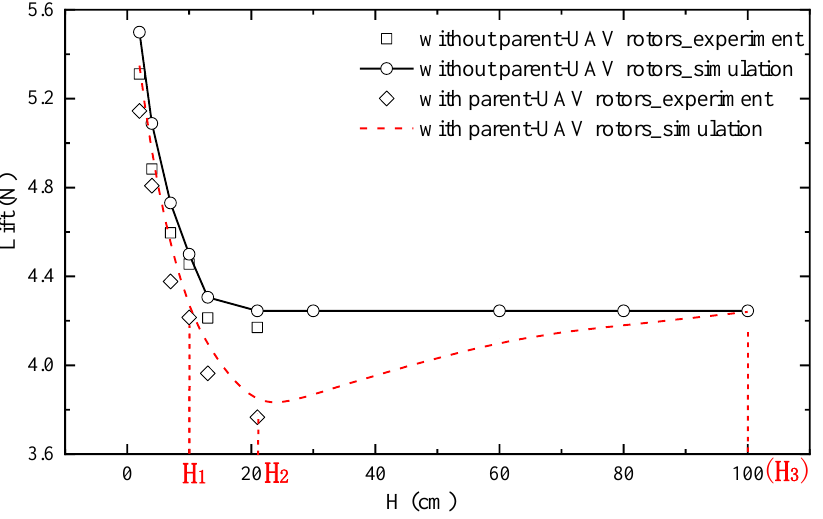
Figure 9. The lift curve of the child UAV in the body interference area. According to the influence intensity of the parent body and the parent rotors, the rotor dominant area and the body dominant area are divided. Figure 10 shows the influence extent of the interference area above the body. Red represents the area where the lift of the child UAV increases, and blue represents the area where the lift decreases. It also means that in the blue area, the role of the parent-rotors is stronger than the role of the parent body, and in the red area, the role of the body is dominant. H1, H2, and H3 are characteristic heights corresponding to those marked in Figure 9.